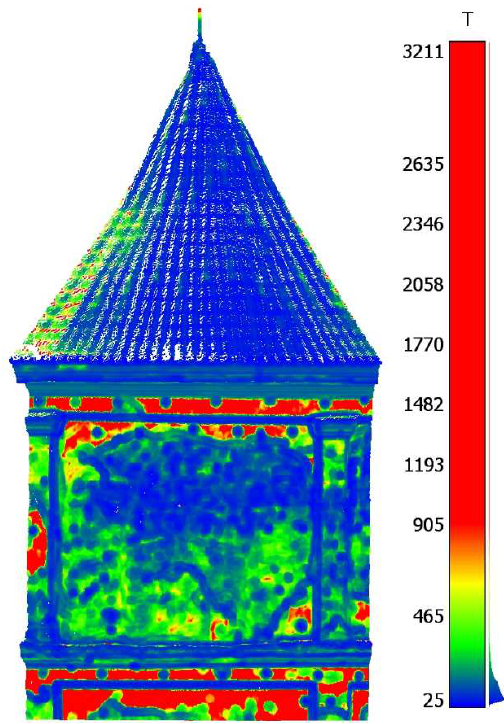
Figure 7. Data 2—original point cloud colored according to the T values; red—flattest parts, blue—most curved/rugged parts.